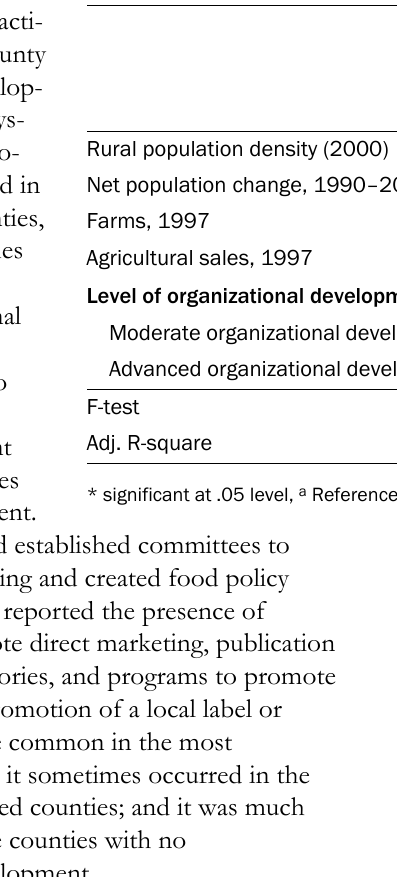
Table 5. Influences on Agricultural and Local Food Development